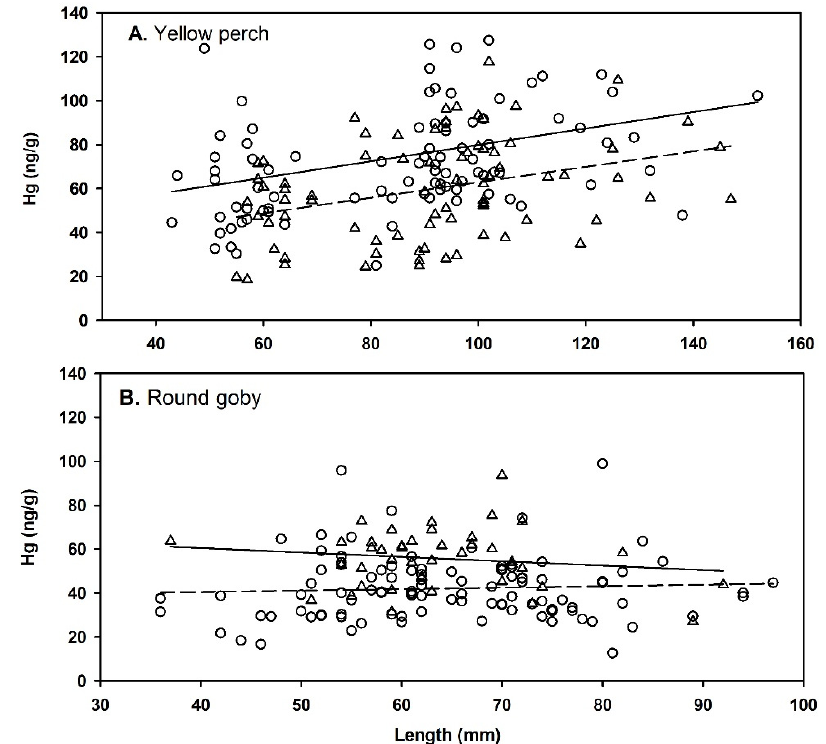
Figure 2. Mercury content of forage fish sampled from sites along Upper St. Lawrence River as a function of habitat and fish length. Legend: Circles and solid lines are sites adjacent to wetlands; triangles and dashed lines are sites non-wetland sites. Symbols are individual fish; lines are linear least squares regressions.